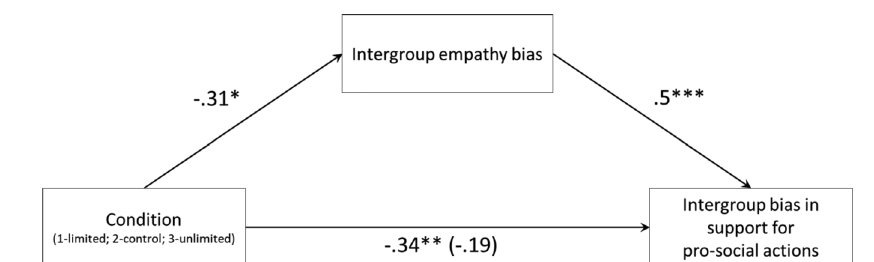
Fig. 4 | A mediation model of the effect of condition on intergroup bias in support for pro-social actions through intergroup empathy bias. A mediation analysis shows that intergroup empathy bias mediates the effect of manipulated